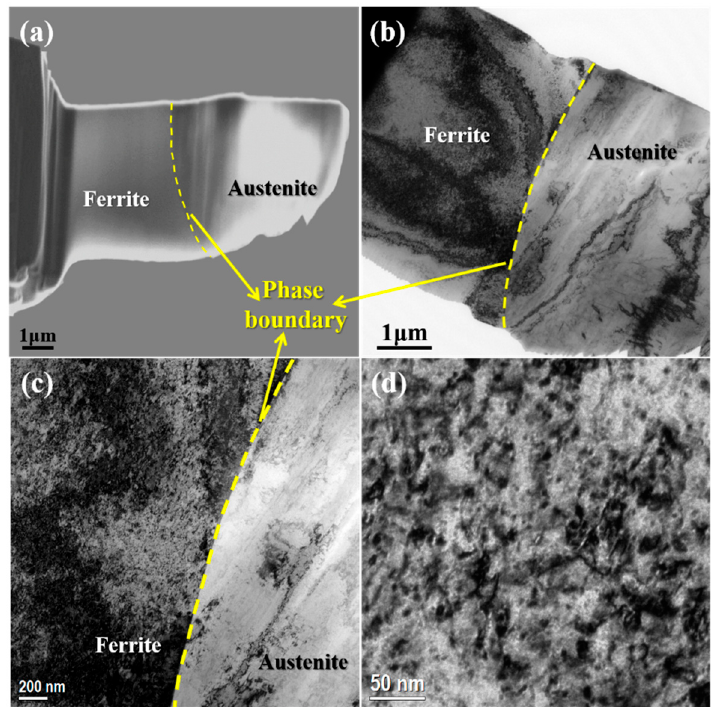
Figure 5. ( a ) SEM and ( b ) TEM images of the overall morphology; ( c ) TEM images of the phase boundary and ( d ) ferrite near the tensile fracture in the thermally aged CDSS.